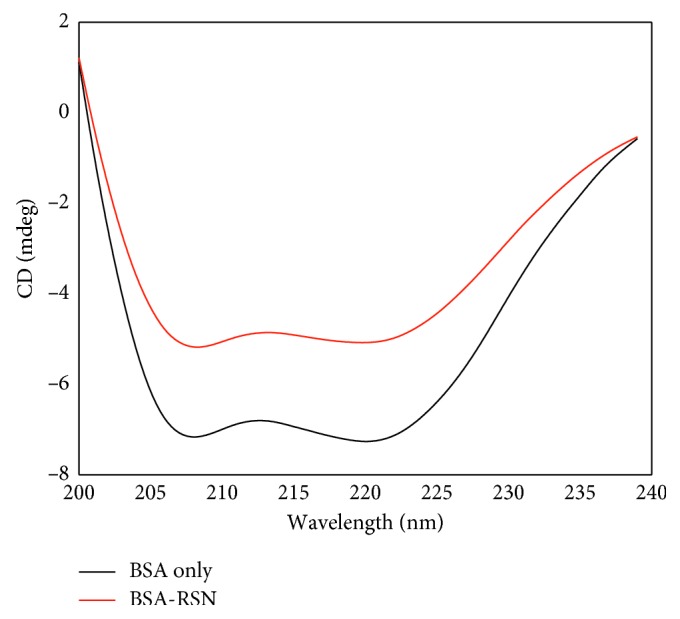
CD spectra of free BSA (black line) and BSA-RSN complex (red line) at pH 7.40 and 297 K. Concentration of BSA : RSN = 1 : 20 (3.5 × 10−6 to 70 × 10−6mol · L−1).